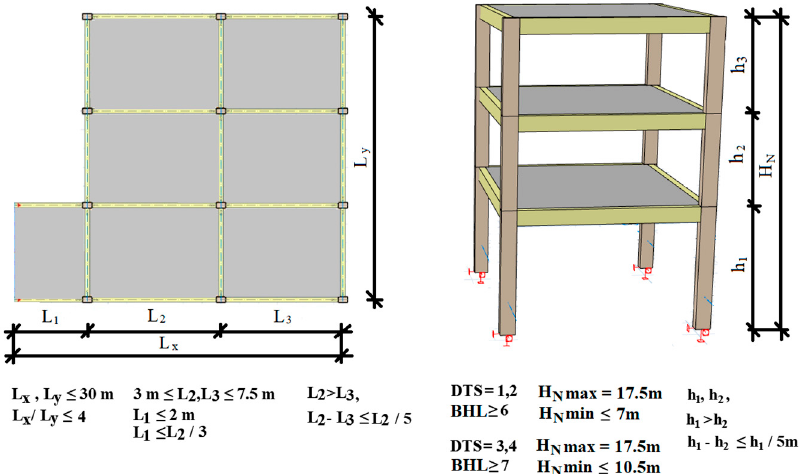
Figure 4. Building height limits according to building floor model plan limit values and earthquake design classes.